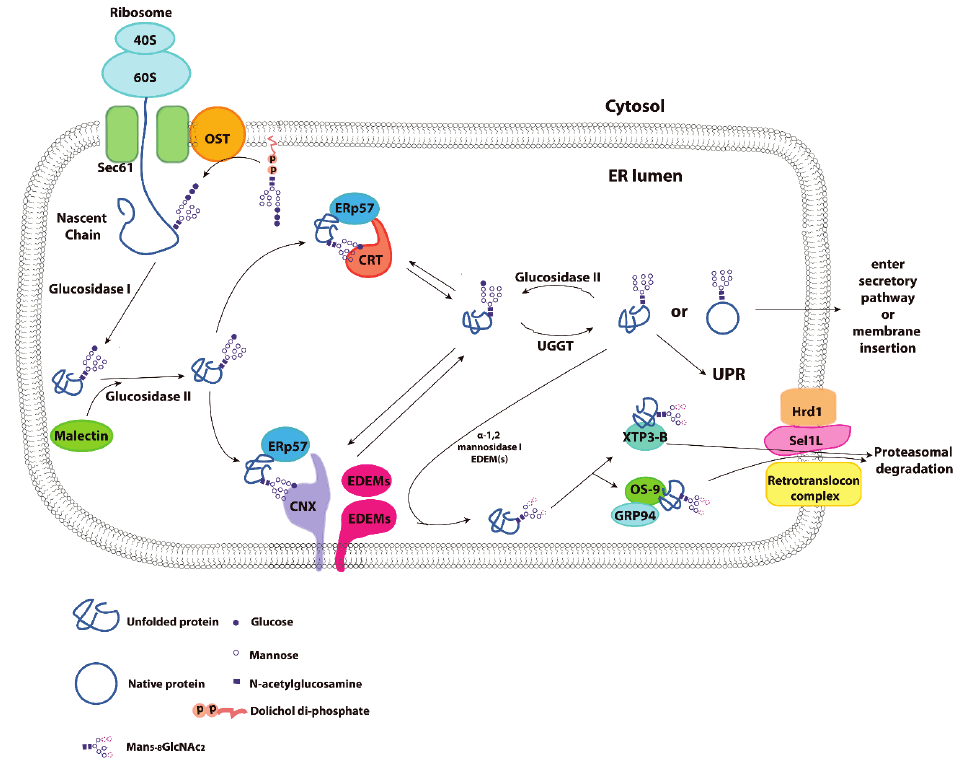
Figure 2. Glycoprotein folding in ER and the calnexin/calreticulin cycle. The folding